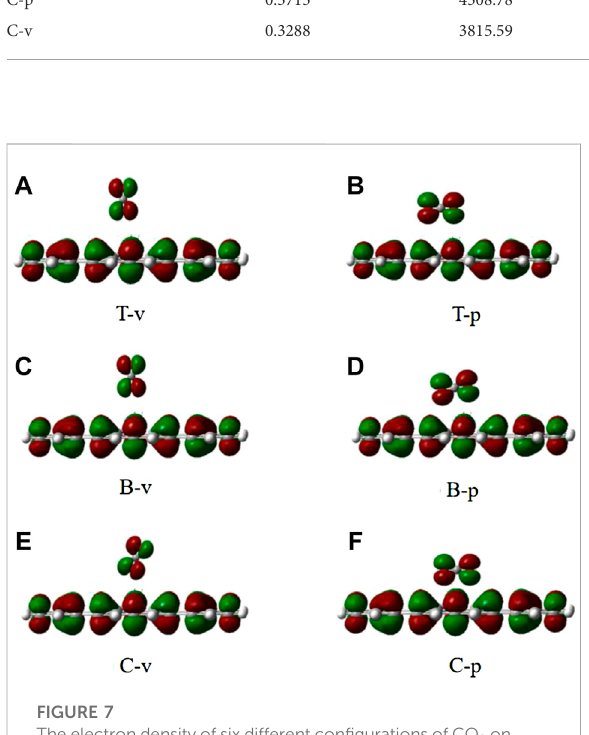
FIGURE 7 The electron density of six different con fi gurations of CO 2 on the graphene-like surface. (A) : T-v, (B) : T-p, (C) : B-v, (D) : B-p, (E) : C-v, (F) : and